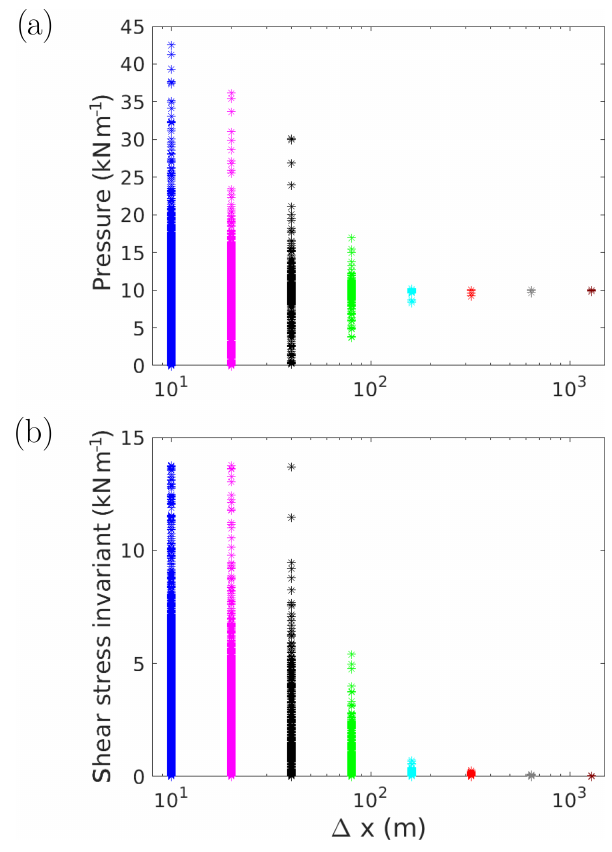
Figure 8. All the values of pressure (a) and of the shear stress in- variant (b) in the 5km × 5km domain as a function of resolution. The thickness field is 2m everywhere except a 1km long, 10m wide horizontal lead in the middle of the domain. The thickness and concentration fields at the other resolutions are obtained through a coarse-graining procedure. The normal stresses at the boundaries are − 10kNm − 1